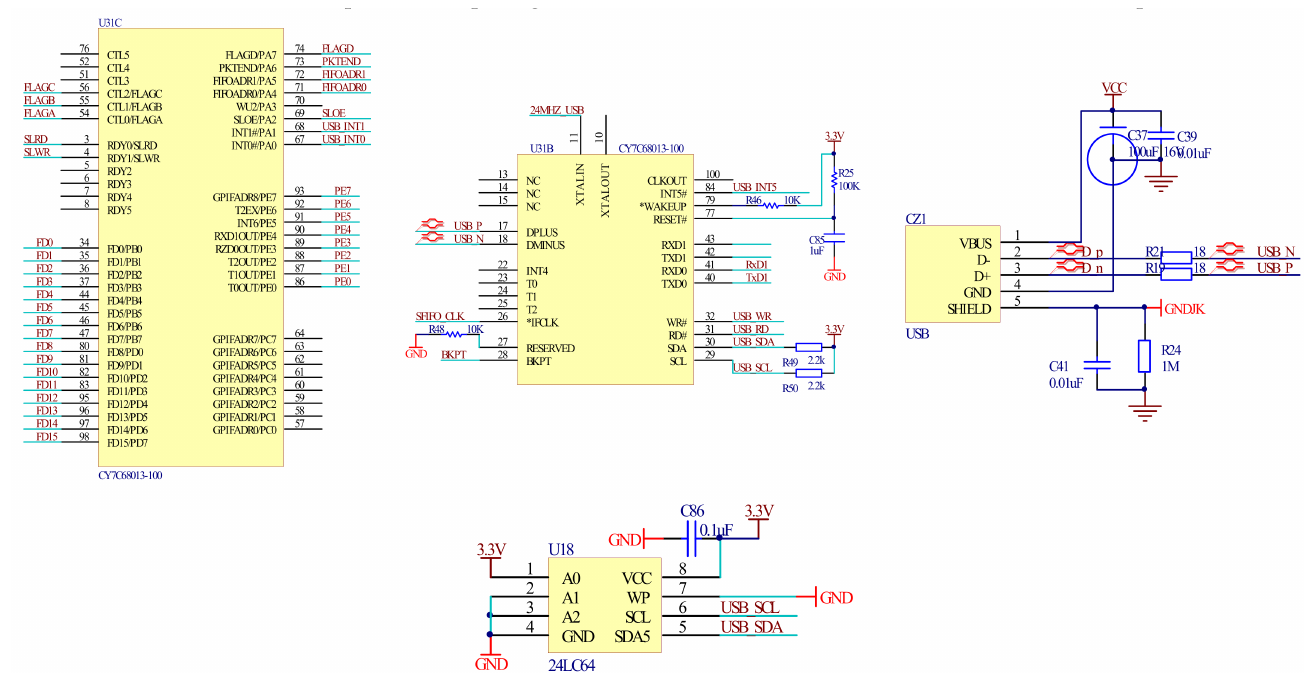
Figure 13. USB interface circuit.